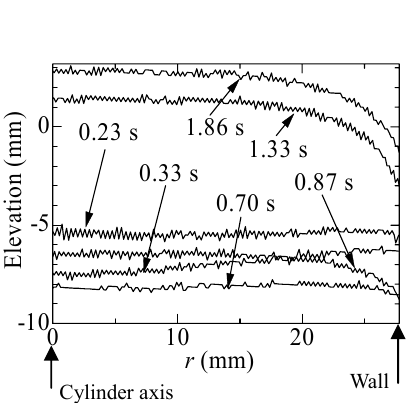
Cylinder Fig. 5 Measured interface profiles at characteristic times in one cycle of excitation.